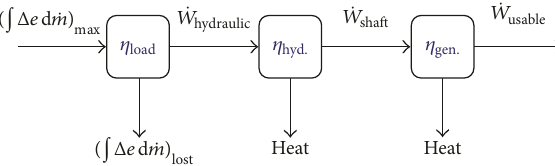
Figure 1: Notation for describing an arbitrary hydraulic installa- tion, including the effective head 𝐻 described in Section 3 of this paper.